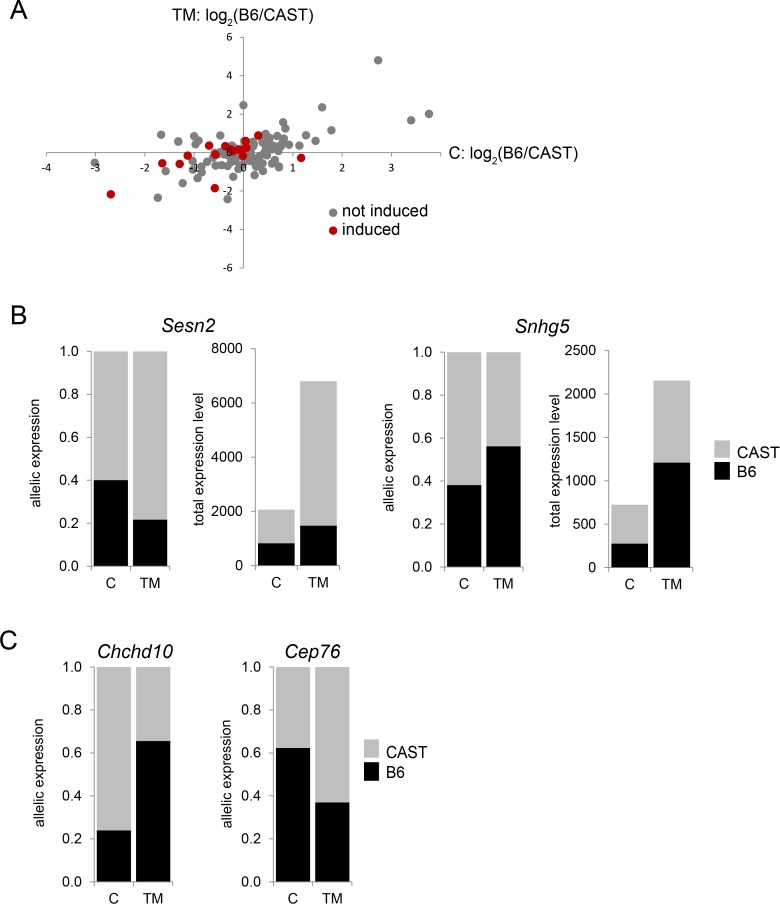
ER stress-induced allele-specific expression (ASE).(A) Genes that show ER stress-induced change in ASE, under control and TM conditions. Genes in red are genes that also show ER stress-induced increase in transcript levels. (B) Sesn2 (Fisher’s exact; q < 4.30 × 10-55) and Snhg5 (Fisher’s exact; q < 5.63 × 10-17) are examples of genes that show ER stress-induced change in ASE and ER stress-induced increase in transcript levels. (C) Chchd10 (Fisher’s exact; q < 9.0 × 10-4) and Cep76 (Fisher’s exact; q < 6.23 × 10-5) are examples of genes that show ER stress-induced change in ASE, but whose transcript is not upregulated by ER stress.